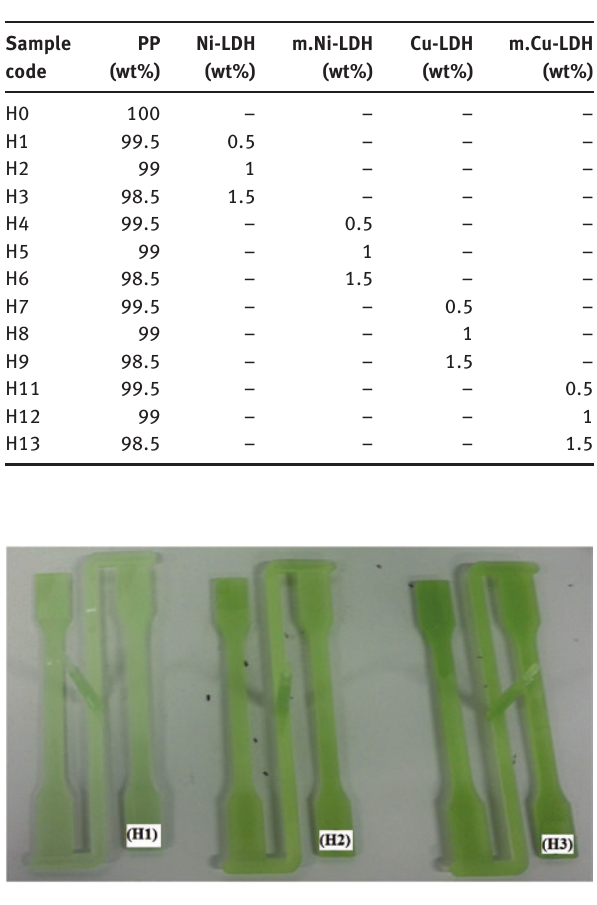
Table 1: Compositions of the PP/LDH nanocomposites.